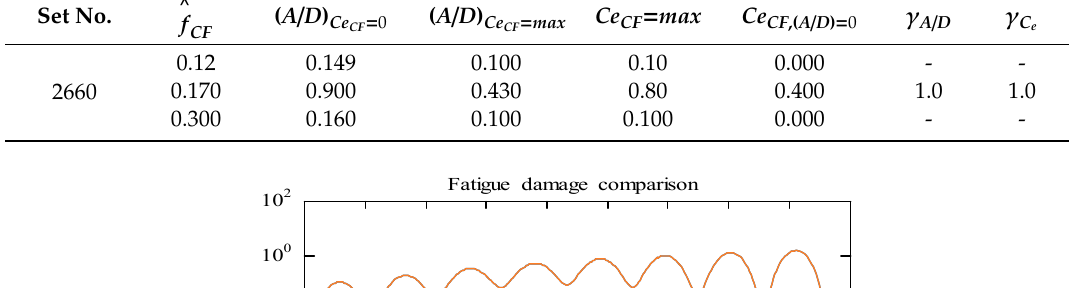
Table 4. Identified optimal parameter set.